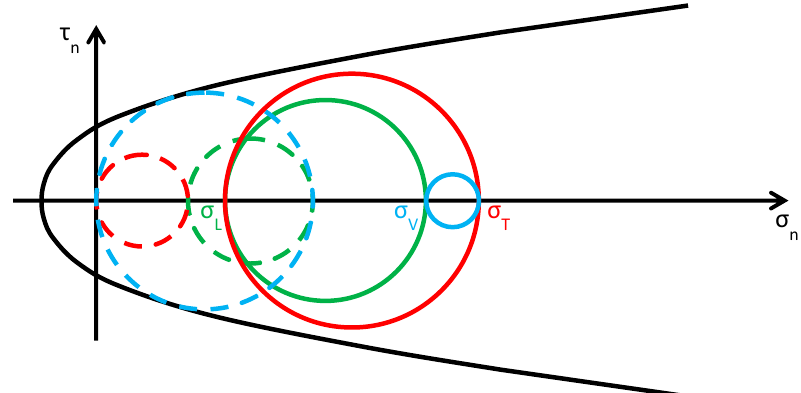
Figure 26. Stress analysis for 𝜎 (cid:3013) (cid:3407) 𝜎 (cid:3021) (cid:3409) 𝜎 (cid:3023) (Mohr’s circles before retrofitting in dashed lines, for comparison).